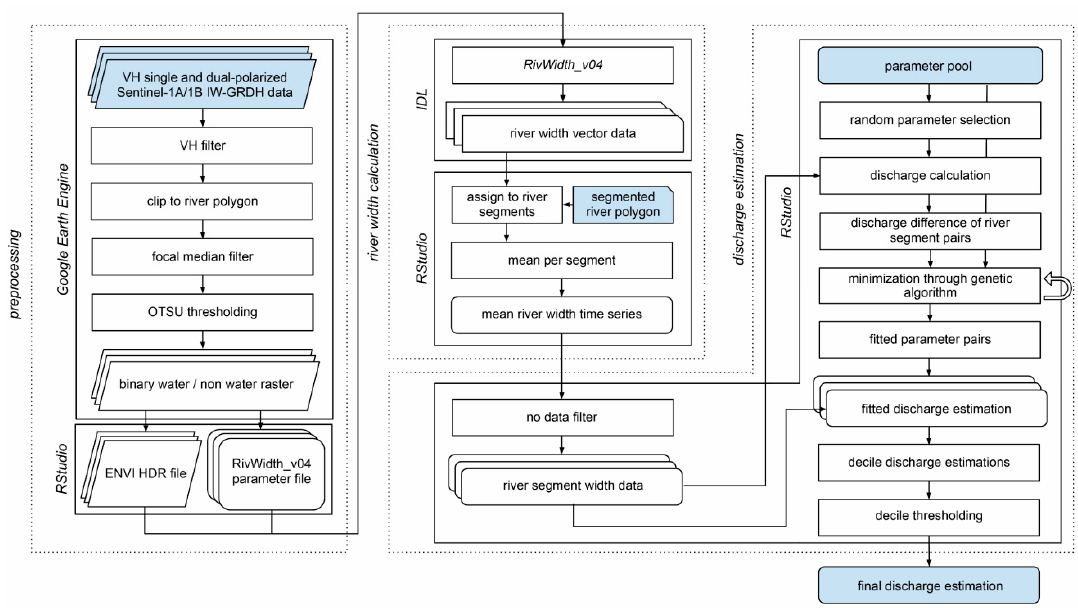
Figure 9. Discharge estimation workflow. The individual Sentinel-1 images are preprocessed within the Google Earth Engine (GEE) and a binary water mask is calculated. Along with the corresponding parameter file, the river width is measured using the RivWidth_v04 software tool and assigned to the river segments. After filtering the output data, the discharge for each river segment is estimated using an iterative genetic algorithm written in RStudio. From the obtained discharge data, decile simulations are created and combined into the final discharge estimation using a thresholding method.